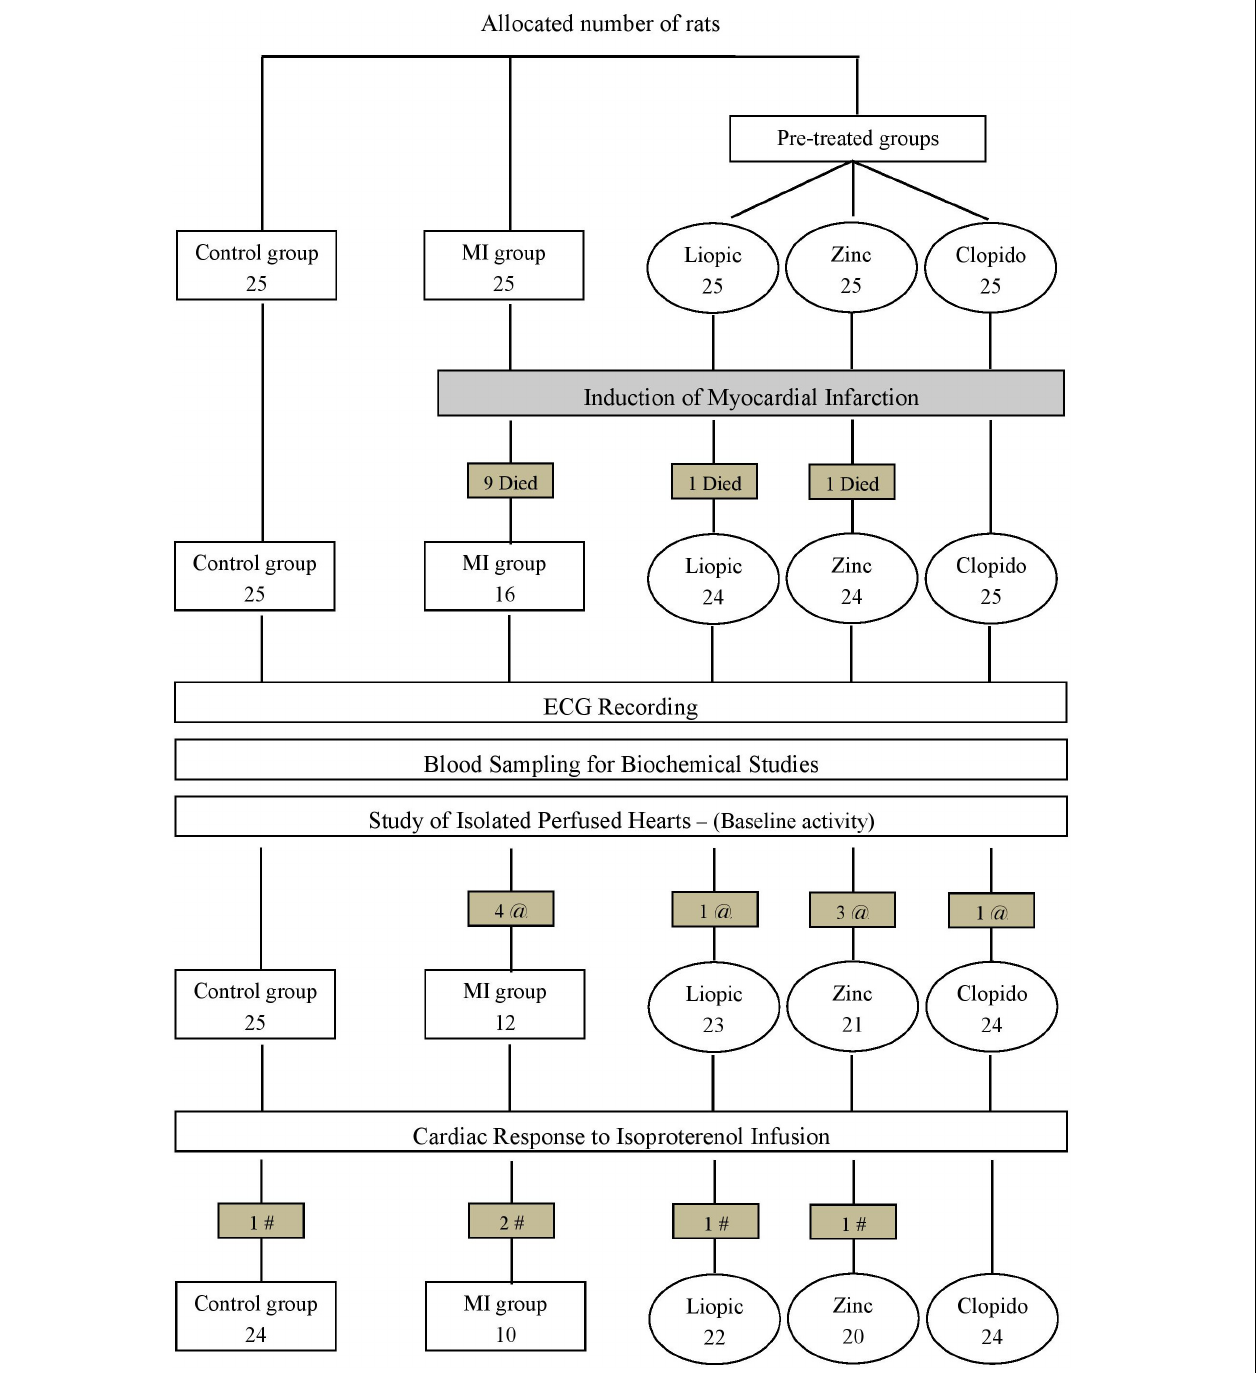
FIGURE 1 | Representative scheme of the experimental protocol. MI, myocardial infarction; Clopido, clopidogrel; @, number of rats with basal arrhythmia; #, number of rats with isoproterenol-provoked